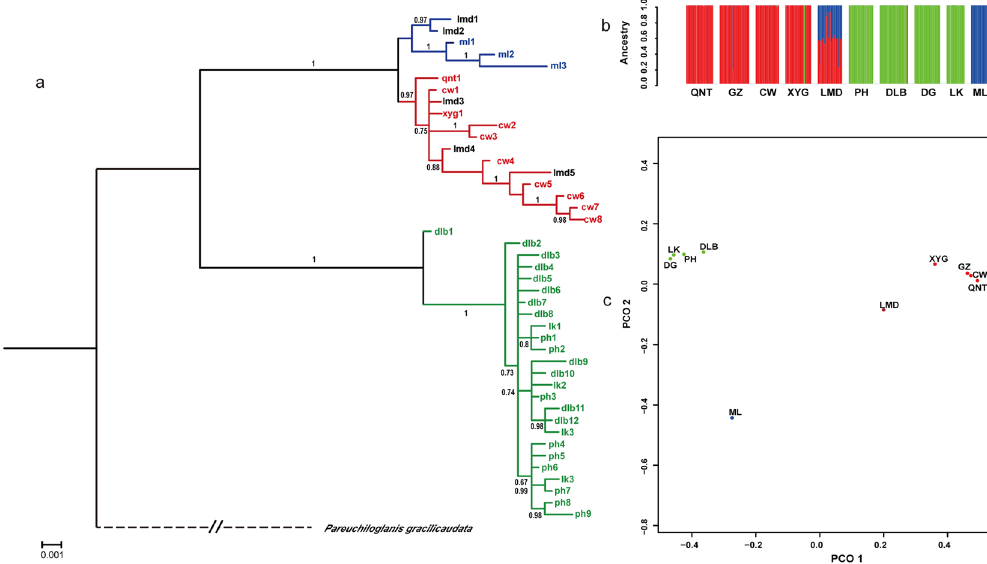
Figure 2. Genetic structure among the ten C. macropterus populations from the Nujiang river. ( a ) Bayesian tree constructed from concatenated mitochondrial haplotypes (2983 bp, GTR + I + G model, not considered sites with gaps). ( b ) Genetic clustering analysis for dataset 1 (1,679 SNPs), genetic clustering graph for the number of clusters (K = 3). Each color represents a different genetic cluster. Bar graphs present the average probability of membership (y-axis) of each individual. ( c ) Principal coordinates analysis (PCoA) plot of the overall average pairwise F ST values of dataset 1.